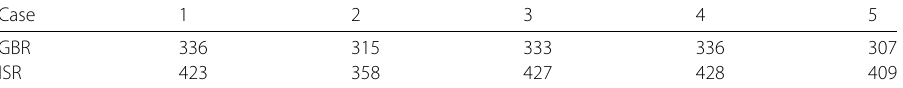
Table 5 Average number of days with imposed quarantine for each case in Scenario